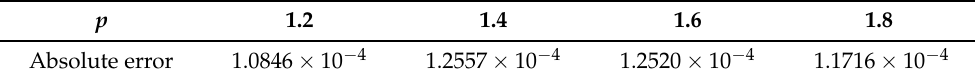
Table 2. The maximum absolute error of the analytic and numerical solutions with different orders p